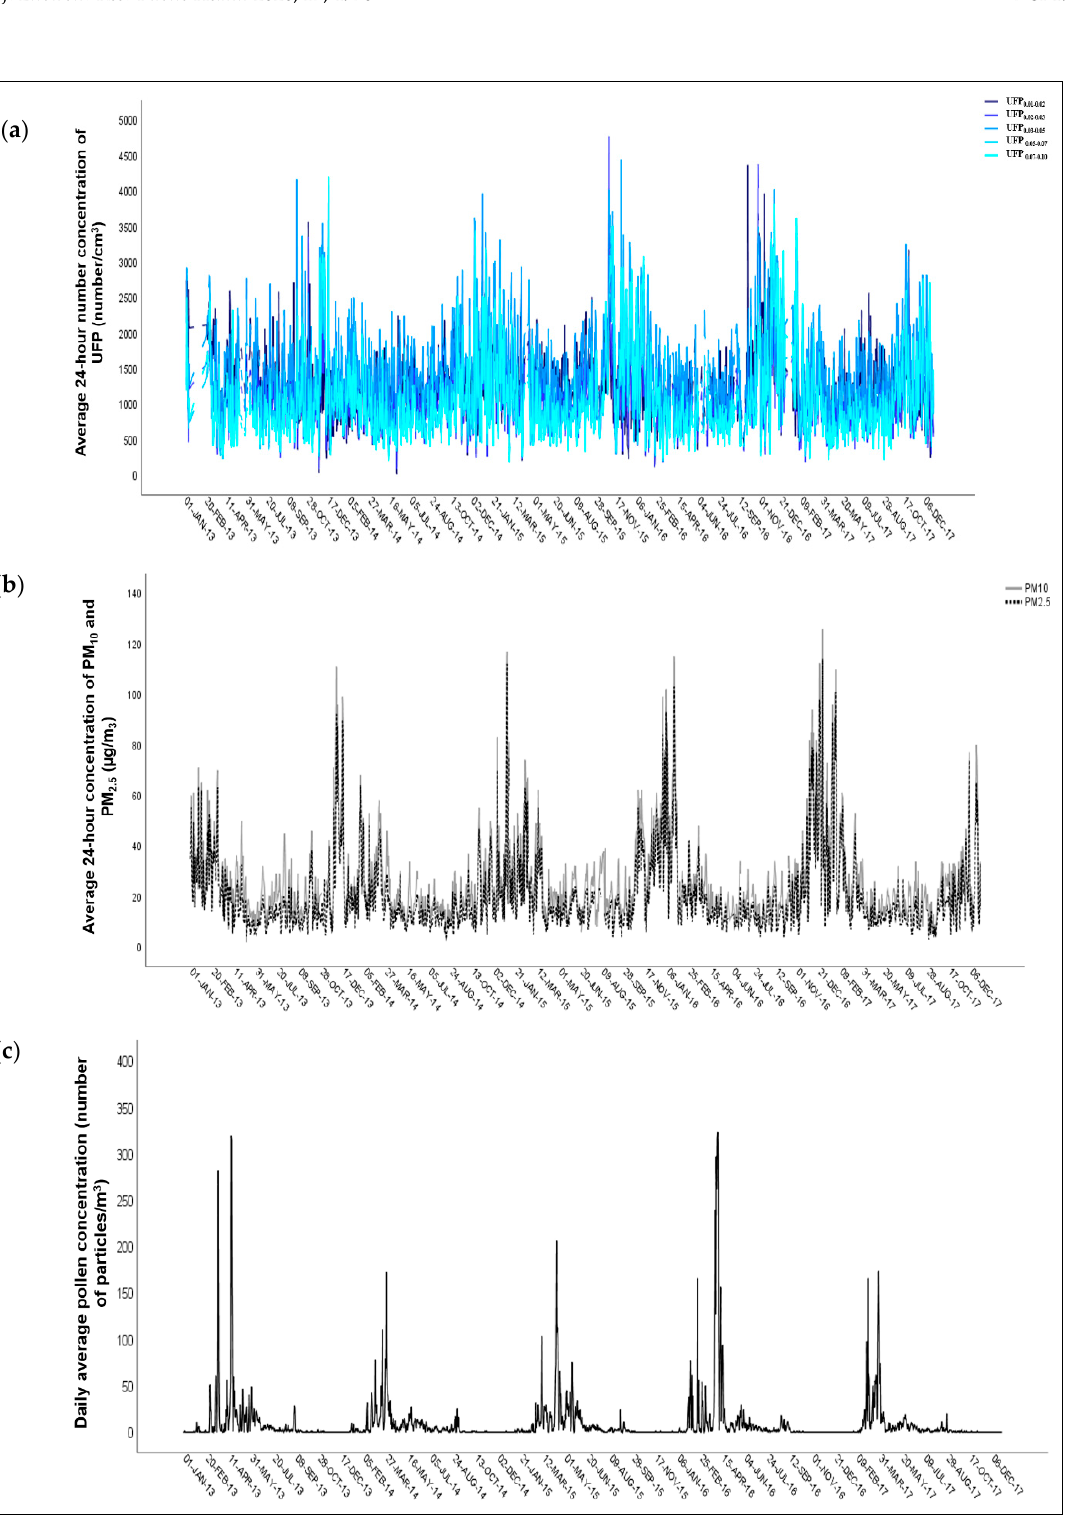
Figure 3. Temporal variability of: (a) average 24-hour number concentration of UFP (number/cm 3 ); ( b ) average 24-hour concentration of PM 10 and PM 2.5 (µg/m 3 ); (c) daily average pollen concentration (number of particles/m 3 ) in the MOL, Slovenia between January 1, 2013 and December 31, 2017.